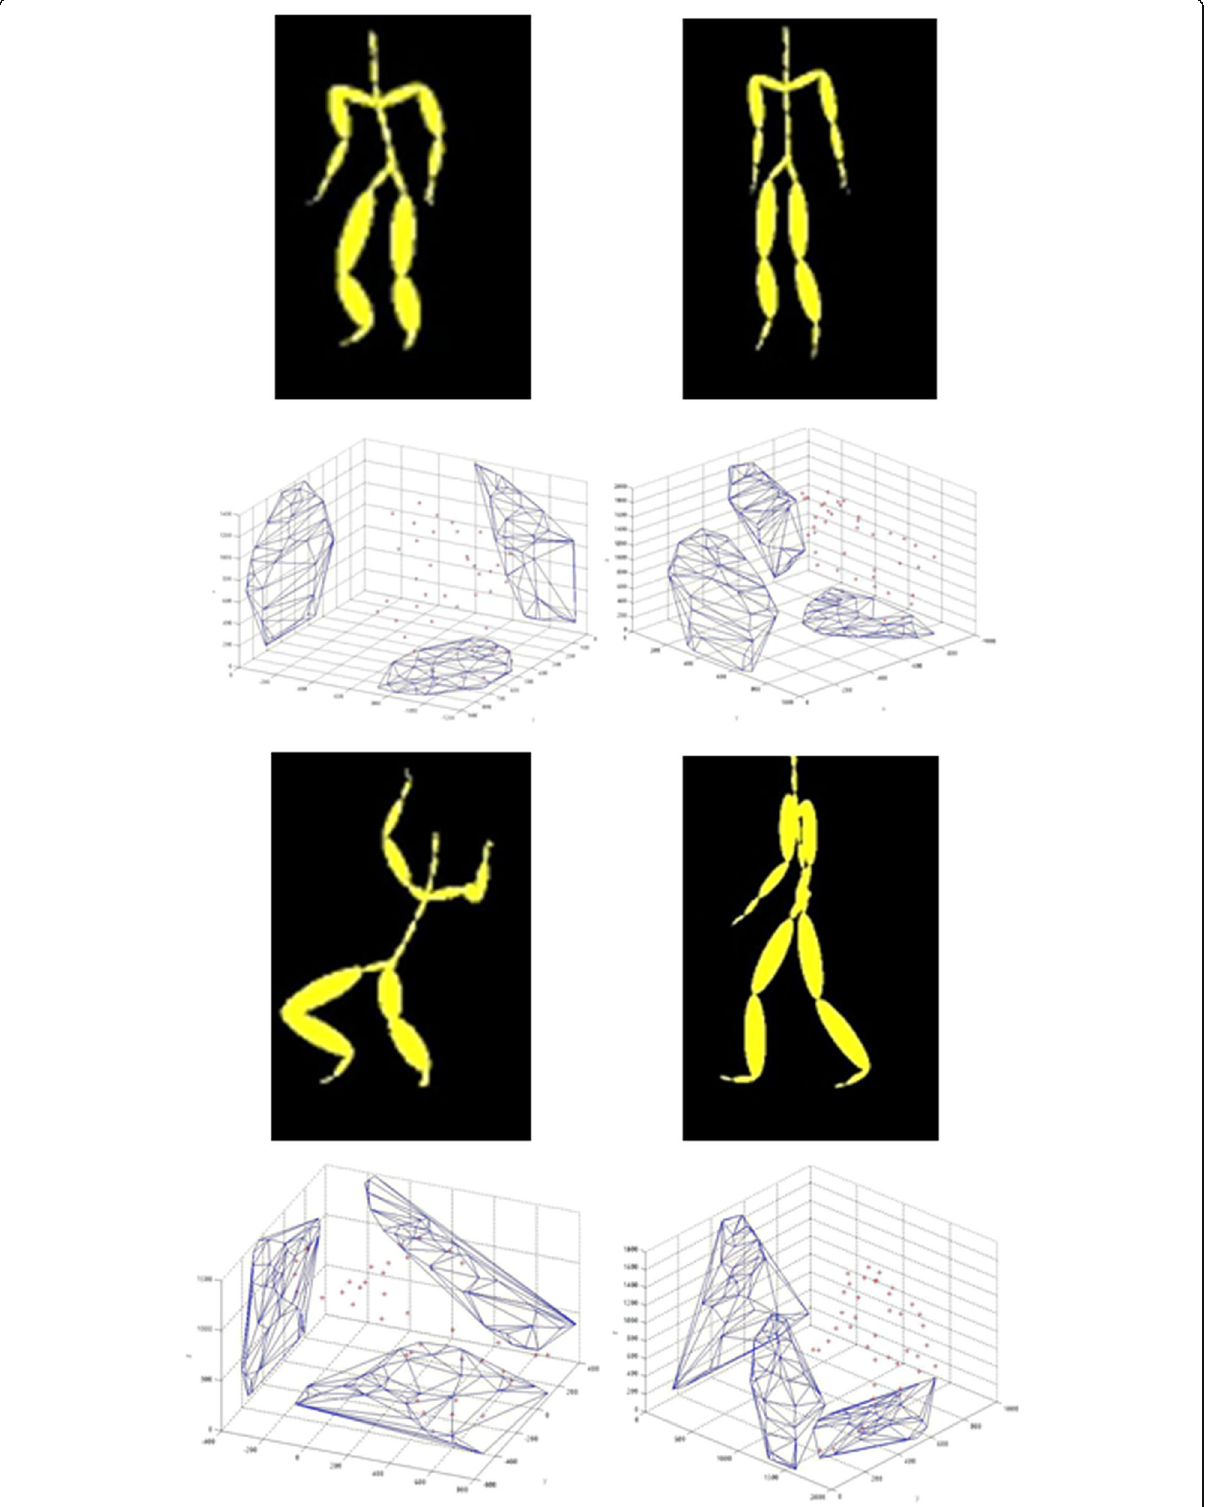
Fig. 5 Posture detection